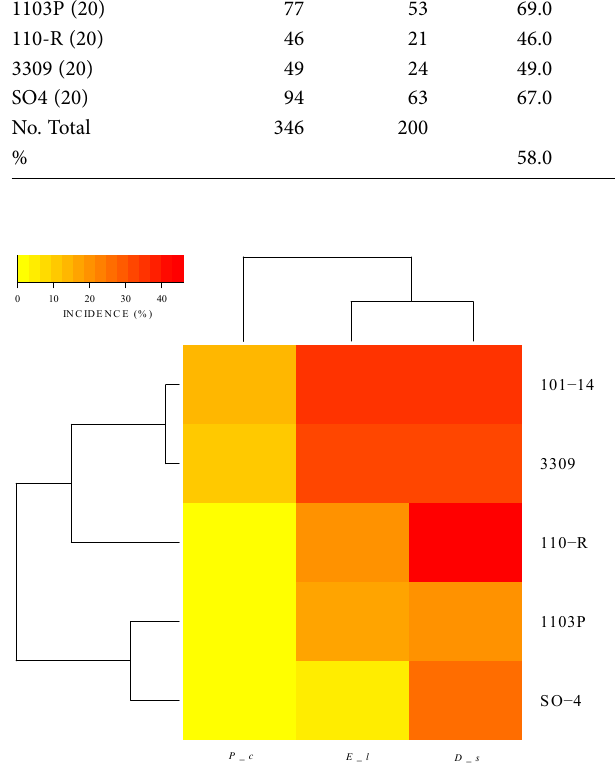
Figure 3. Heatmap with GTDs fungal distribution in the five root- stocks considered on this study. P_c: Phaeomoniella chlamydospora, E_l: Eutypa lata and D_s: Diplodia